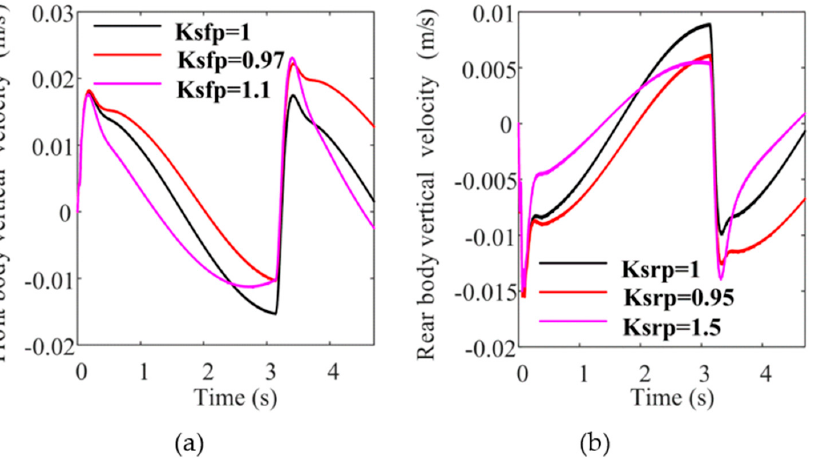
Figure 6. Suspension stiffness mismatch effect. ( a ) Front suspension stiffness mismatch effect; ( b ) Rear suspension stiffness mismatch effect.